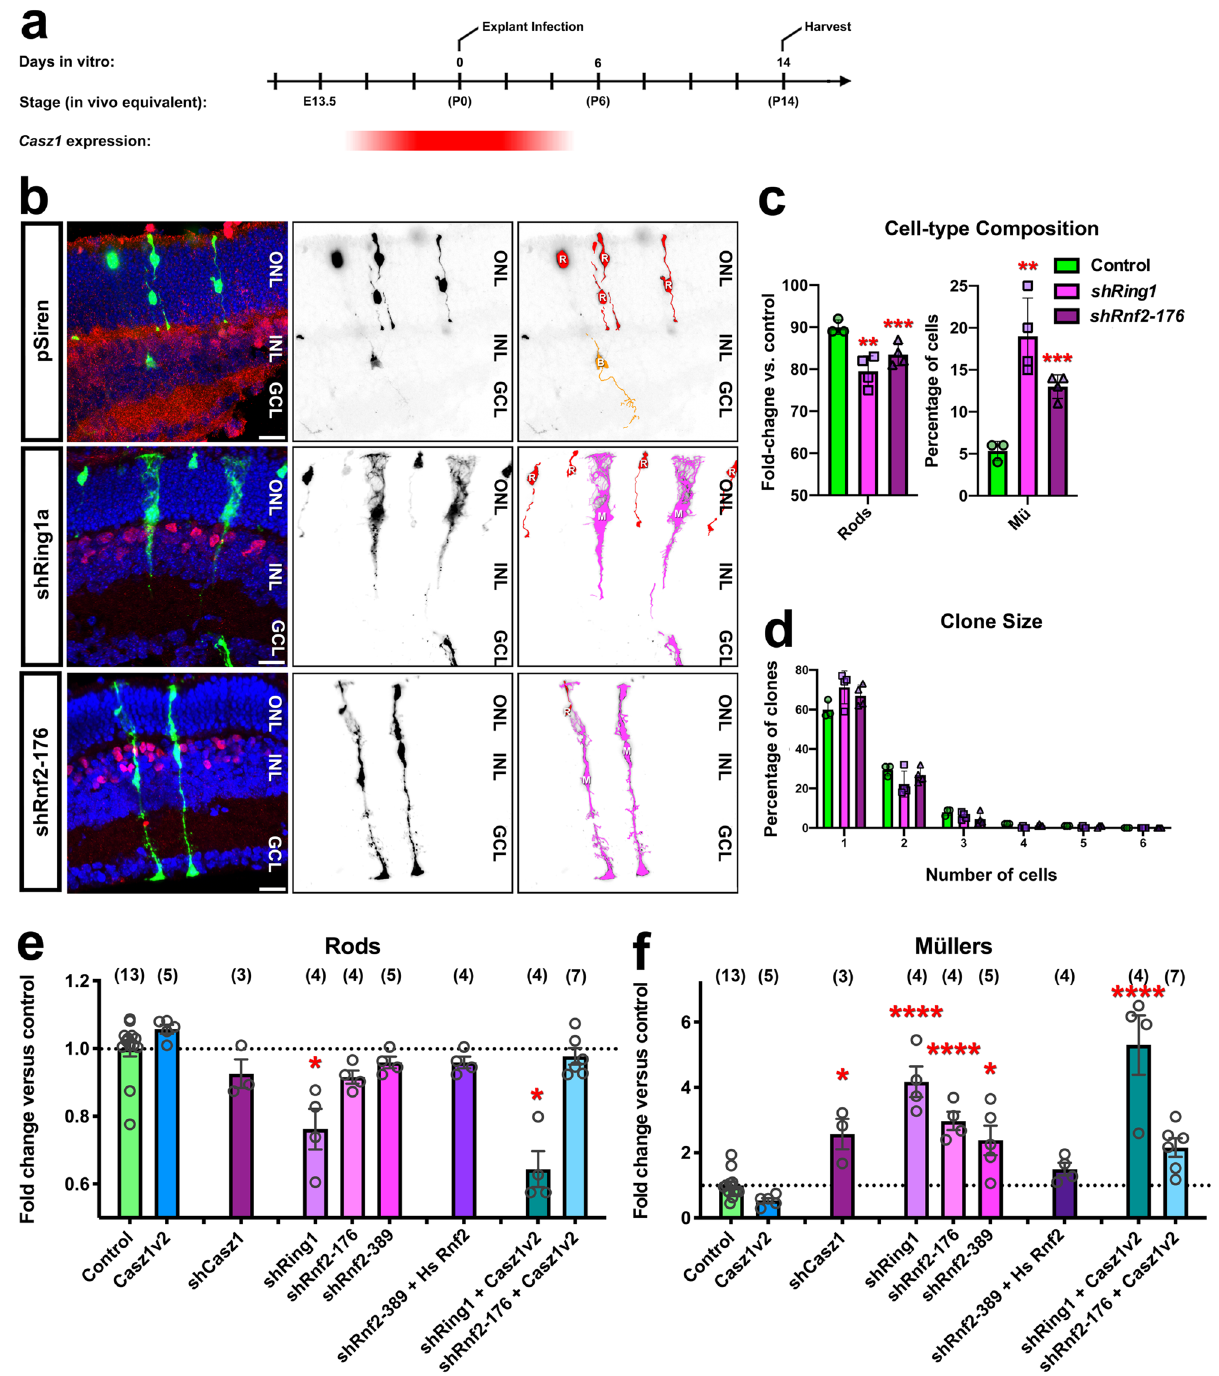
Figure 5. Casz1 requires polycomb to control retinal progenitor output. ( a ) Experimental timeline. ( b ) Examples of vector control (pSiren; n = 3) or shRNA clones (n = 4) that were transduced at P0 and cultured for 14 days in vitro, marked by ZsGreen expression (green). Sections were stained for Vsx2 (red) and Hoechst (blue). Scale bars = 20 microns. ( c,d ) Cell-type composition ( c ) and clone size distribution ( d ) of the resultant clones. See Table S5 for statistical summary. ( e,f ) Combinatorial expression/co-expression of Casz1 and polycomb loss or gain-of-function constructs. P0 retinas were electroporated with the indicated construct combinations, and harvested after 14 days in vitro. The proportion transfected rods ( e ) or Müller glia ( f ) was quantitated and normalized to the proportions obtained in control transfections. The control was pooled from overexpression (pCIG2: n = 8) and shRNA (pSiren: n = 5) vector transfections. The asterisks denote significant differences versus control as determined by one-way ANOVA with Tukey’s post-hoc test. n-values are presented in parentheses. *p < 0.05; **p < 0.01; ***p <